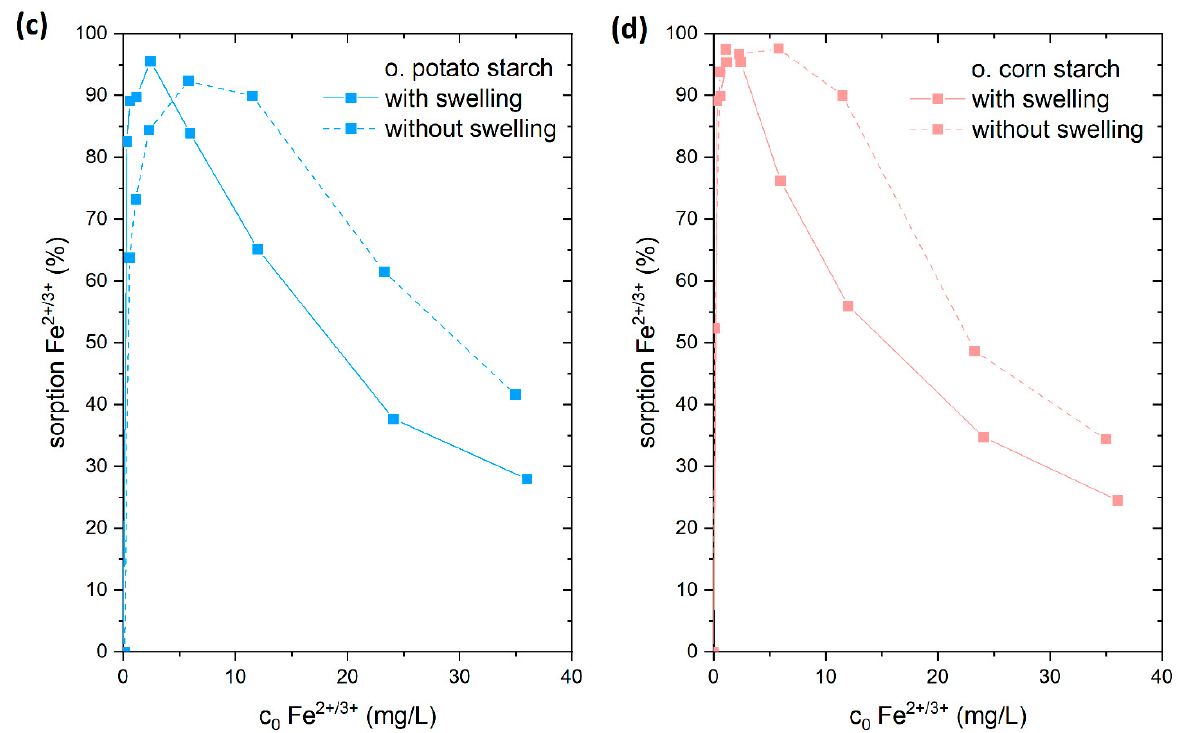
Figure 8. Adsorption of Fe 2+ from FeSO 4 solution with (connected by solid line) and without swelling (connected with dashed line) on ( a ) native potato starch (blue); ( b ) native corn starch (red); ( c ) oxidized potato starch (light blue); and ( d ) oxidized corn starch (pink).